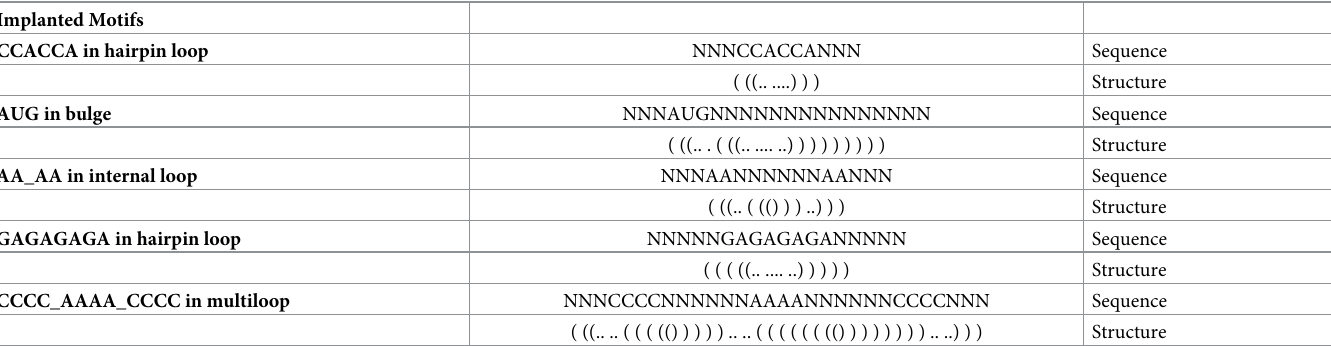
Table 1. Implanted RNA motifs in recovery analysis as described in Section 2.7.